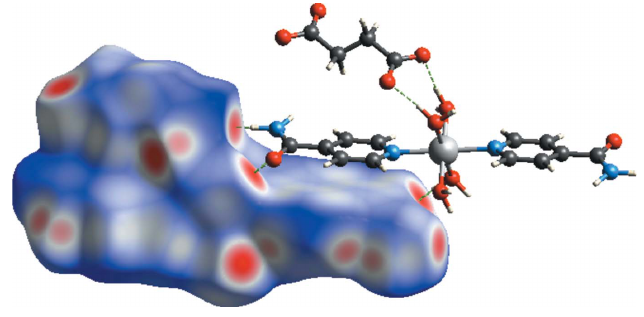
Figure 3 d norm mapped on the Hirshfeld surfaces to visualize the intramolecular and intermolecular interactions of the title